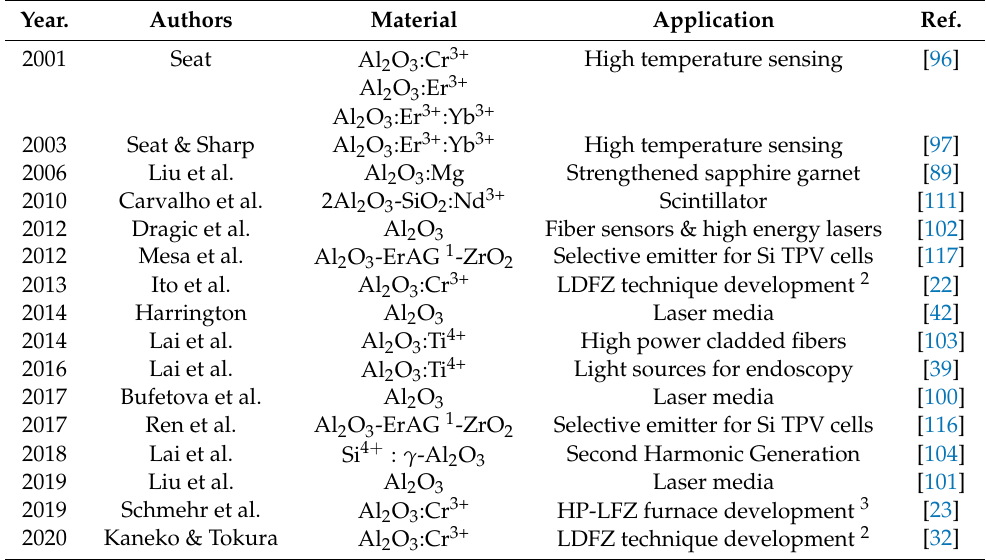
Table 3. Sapphire (Al 2 O 3 ) and ruby (Al 2 O 3 :Cr) fibers produced by LFZ since 1999 [8]. Year.